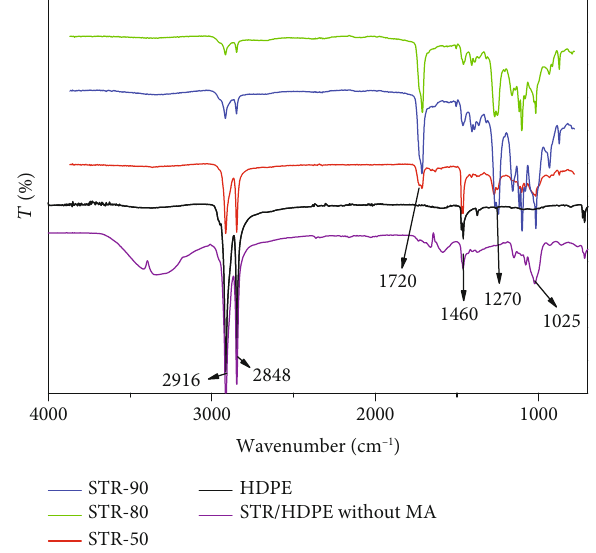
Figure 1: FT-IR spectrum of starch-based composite fi